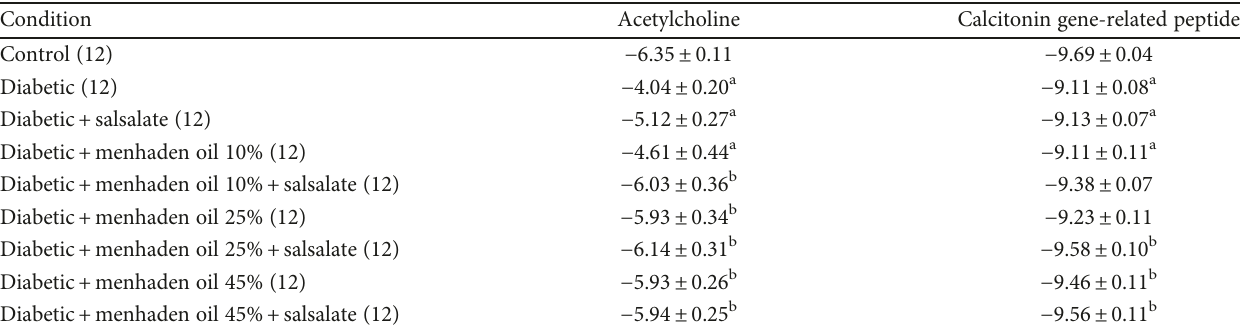
Data are presented as the mean ± SEM . a P < 0 05 compared to control rats. b P < 0 05 compared to diabetic rats. Parentheses indicate the number of experimental animals.